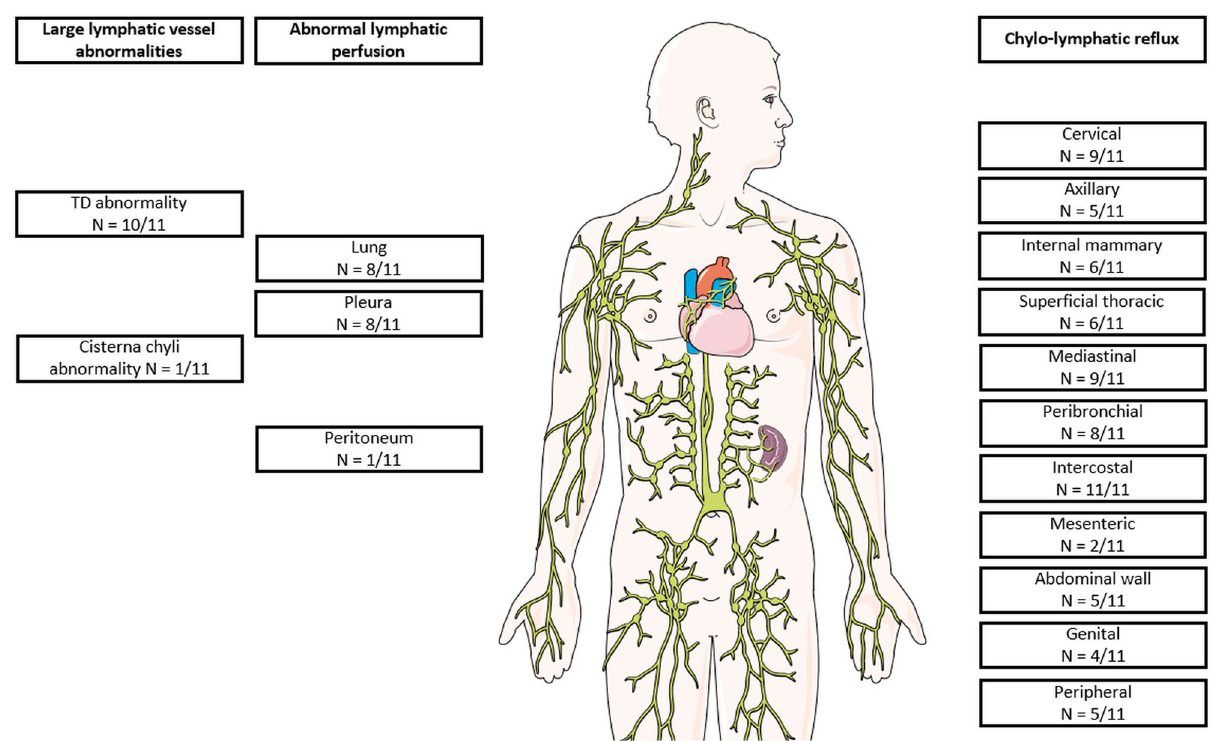
Figure 7. Overview of major imaging findings on DCMRL (image: